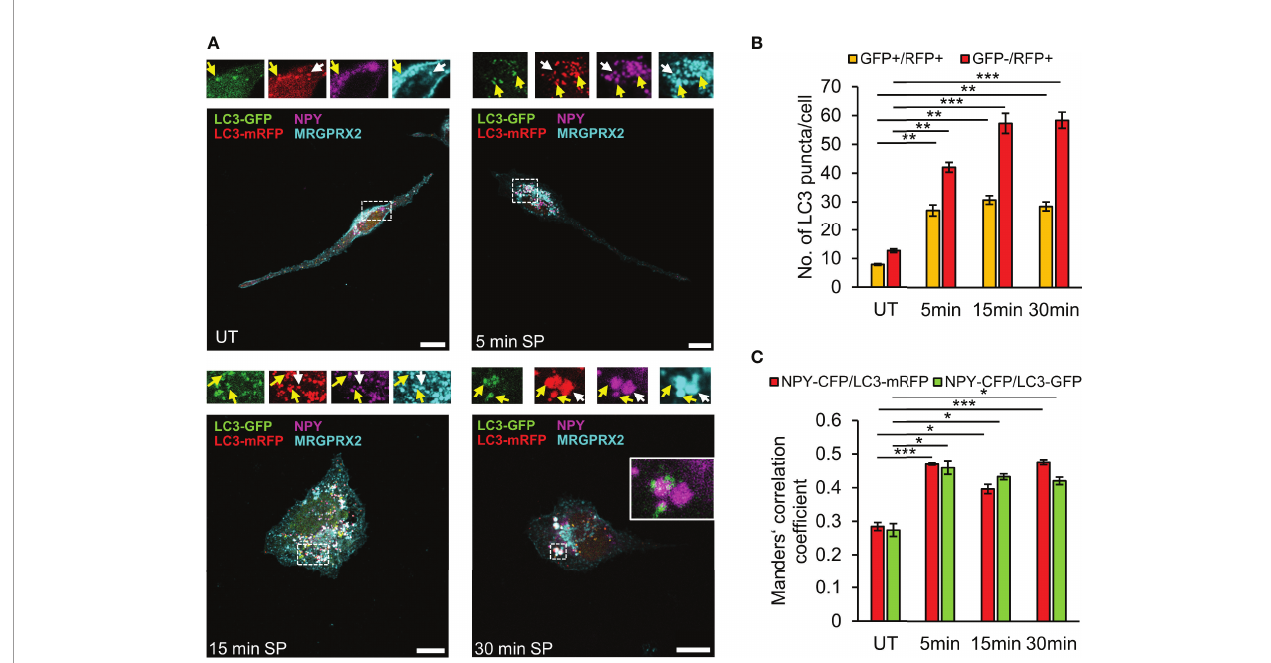
FIGURE 5 | SP stimulates fusion of LC3-positive SGs with lysosomes. RBL-MRGPRX2 cells, transiently co-transfected with NPY-CFP (magenta) and LC3-GFP-mRFP (green and red), were either left untreated (UT) or triggered for the indicated time periods with 10 µM SP. Cells were subsequently immunostained with anti-HA antibodies followed by Alexa Fluor ® 647-conjugated secondary antibodies (pseudo colored cyan) (A) . Enlargements correspond to the boxed areas. Yellow arrows point to MRGPRX2 that is localized to LC3-positive-SGs (GFP + /mRFP + ), and white arrows point to MRGPRX2 that is localized to LC3-autolysosome-SGs (GFP - /mRFP + ). An example of the merge of NPY-CFP and LC3-GFP is shown in the inset of the 30 min image. Scale bars = 10µm. The average number of double positive GFP + /mRFP + vesicles or single GFP - /mRFP + vesicles was quanti fi ed using the ImageJ software and is presented as the mean ± SEM from fi ve independent experiments, with each experiment including at least 20 cells/condition (B) . The extent of colocalization of NPY-CFP with LC3-mRFP or LC3-GFP was quanti fi ed (n = 3) and is presented as Mander ’ s correlation coef fi cient (C) . Statistical signi fi cance was determined by one-way ANOVA, followed by Dunnett ’ s post-test. * P < 0.05, ** P < 0.01, *** P <